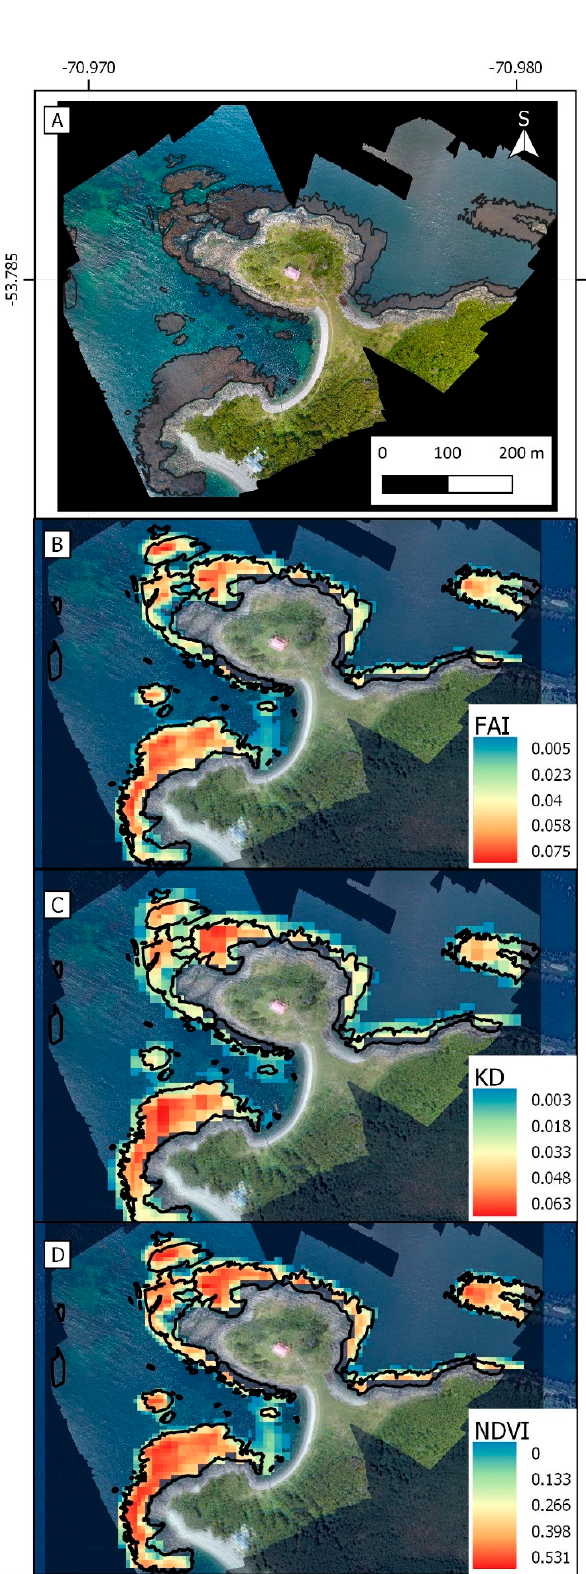
Figure 5. Ground-truthing process. A: ‘True’ canopy is delineated as the black line in the UAV orthomosaic. B, C, and D: maps obtained through the kelp filter algorithm applied on the Floating Algae Index (FAI), the Kelp Difference (KD) and the Normalised Difference Vegetation Index (NDVI), respectively. Higher values show higher concentrations of kelp canopy, although each index shows different levels of sensitivity. Site: San Isidro (Strait of Magellan). Cartographic projection EPSG: 3857, South-oriented.